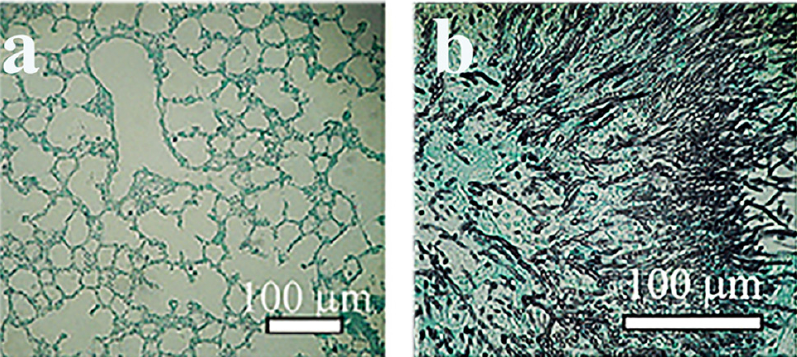
Figure 4. Grocott’s methenamine silver (GMS) staining to detect aspergillosis in the lung tissue of mice. ( a ) Control lung section. ( b ) Staining of lung section in immunocompromised mice 96 h after infection. Modified with permission [94].